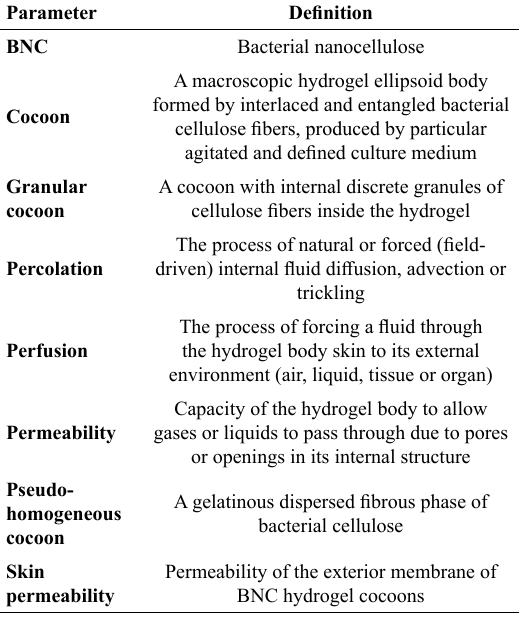
Table 1. Glossary of hydrogel characteristics and hydromechanical flow-relatated